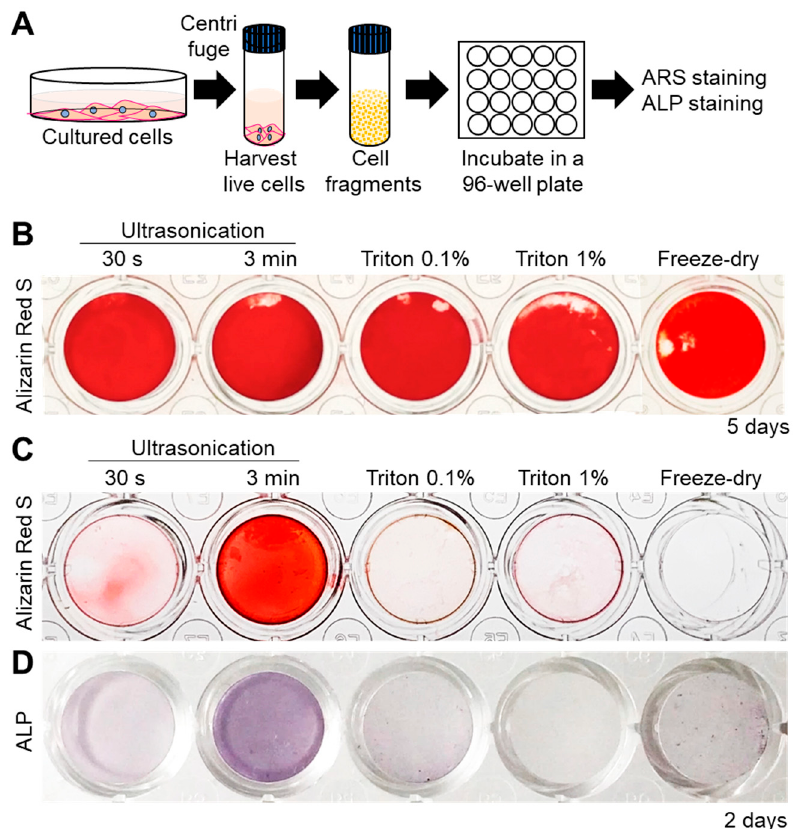
Figure 2. ( A ) Experimental protocol for cell nanofragment mineralization and staining. Cell fragments were obtained from ATDC5 cells by the 5 di ff erent methods and incubated at a concentration of 300 µ g / mL in α -MEM supplemented with 10 mM β -glycerophosphate ( β -GP) for up to 5 days. ( B ) Alizarin Red S (ARS) staining showing that all cell fragments prepared by the 5 di ff erent methods mineralized within 5 days. ( C ) Cell nanofragments obtained by ultrasonication 3 min showed markedly faster mineralization (after 2 days) compared to those obtained by the other methods. ( D ) Alkaline phosphatase (ALP) staining showed a high ALP activity in the cell nanofragments obtained by 3 min ultrasonication.